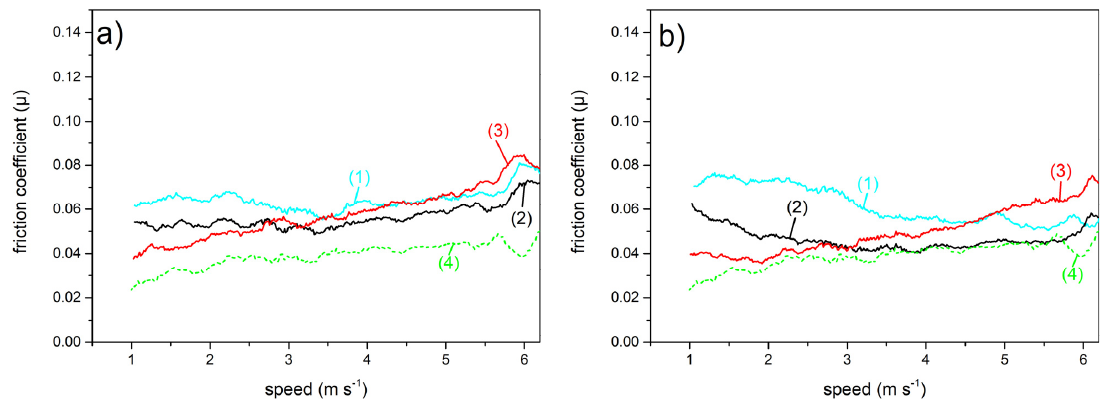
Figure 6. Friction coefficient of AISI 301H LIPSS as a function of the gliding speed on snow at different temperatures: − 10 °C (cyan curve, 1); − 5 °C (black curve, 2); − 3 °C (red curve, 3). For comparison, the µ trend for parallel gliding at − 3 °C of stone grinded and waxed UHMWPE (dashed green curve, 4) is shown; ( a ) parallel gliding; ( b ) perpendicular gliding.